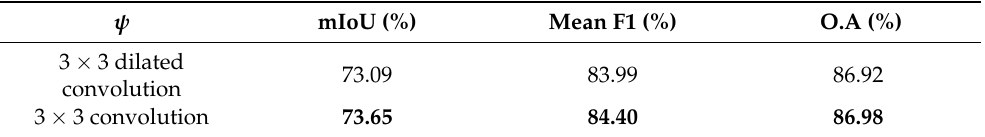
Table 3. The effect of different convolution variants for ψ in the TSIF module using the UDD-6 dataset.